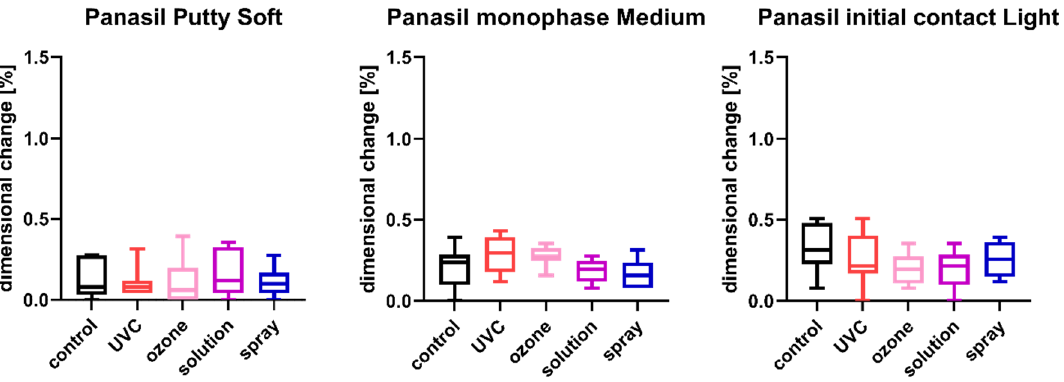
Figure 2. Linear dimensional change in A-silicones (Panasil Putty Soft, Panasil monophase Medium, and Panasil initial contact Light) after disinfection using various methods.